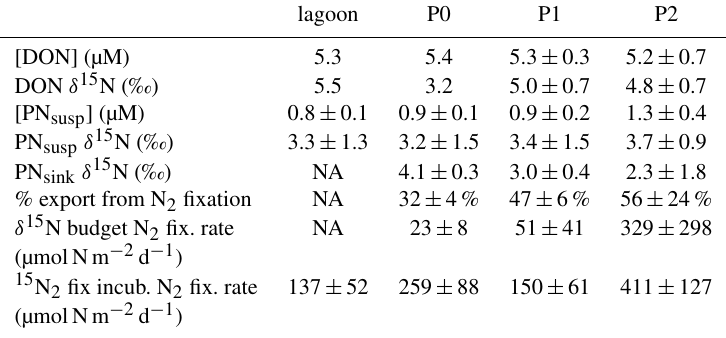
Table 1. Average concentrations ( ± 1SD; µM) and δ 15 N (‰) for organic N pools and fluxes in the VAHINE mesocosms during P0 (days 1 through 4), P1 (days 5 through 14), and P2 (days 15 through 23), as well as in the lagoon waters outside the mesocosms. Additionally, the average ( ± 1SD) fraction of export supported by N 2 fixation based on δ 15 N budget calculations, as well as the average ( ± 1SD) N 2 fixation rate for each time period based on both δ 15 N budget calculations and 15 N 2 incubations (Berthelot et al., 2015), are reported. Note that DON concentration and δ 15 N for the lagoon and P0 are based on one measurement, so no standard deviation is included. DIN pool concentrations were low (i.e., <0.1µM) and invariant throughout the experiment (Berthelot et al.,